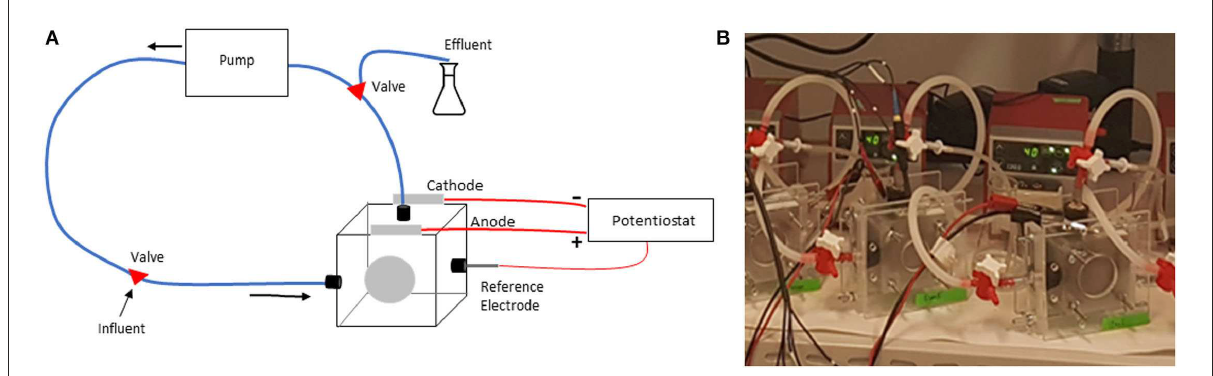
FIGURE1 (A) A schematic illustration of the reactor setup, (B) a photo of the reactor setups in the lab.